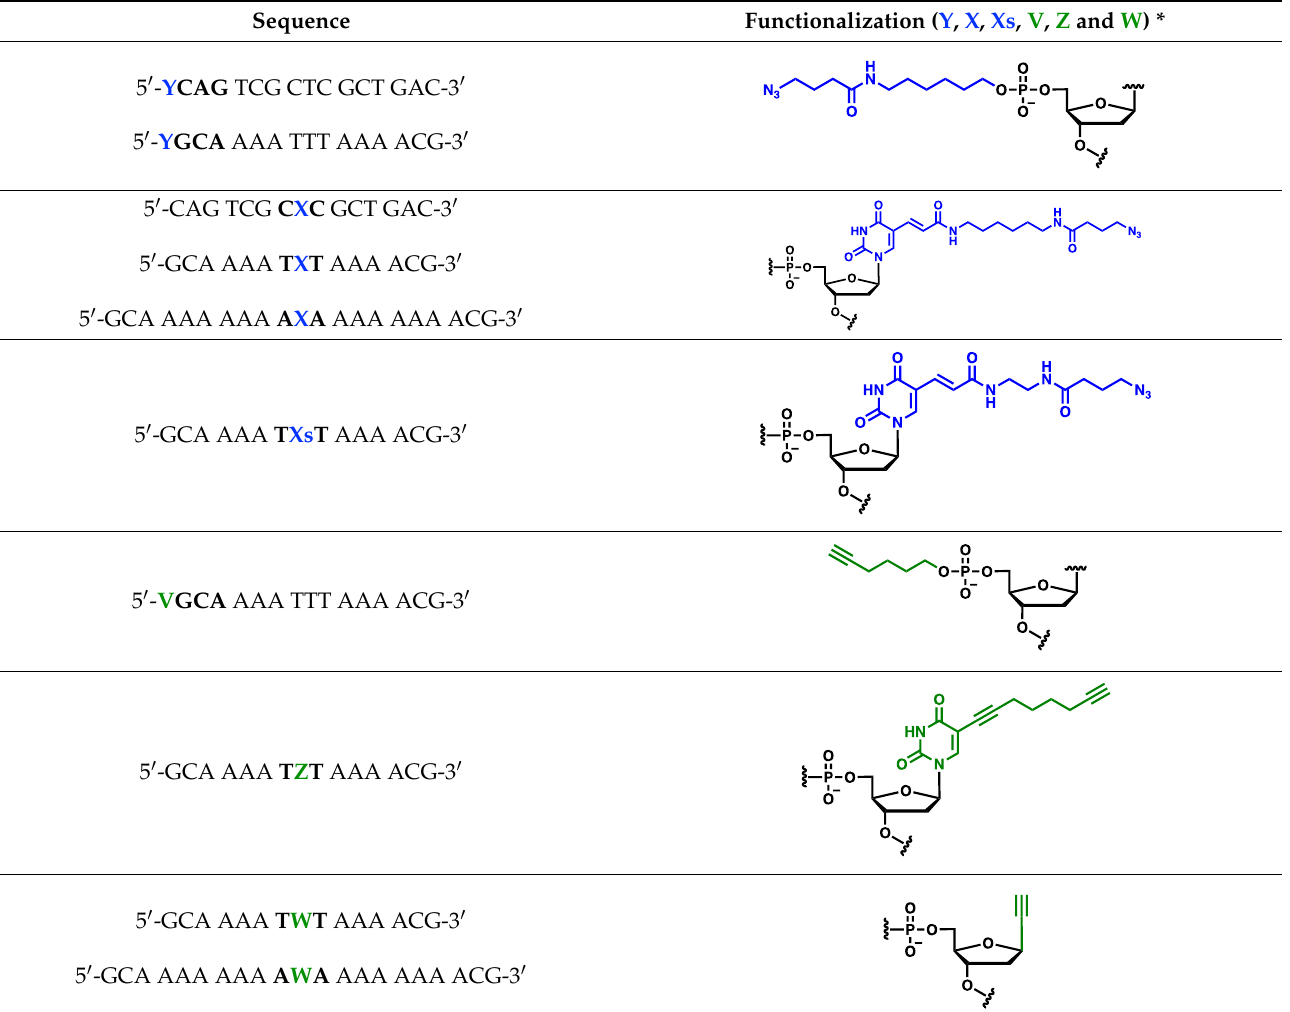
Table 1. Azide- and alkyne-functionalized ODNs used for post-synthetic fluorescent labeling with engineered dyes. Sequence